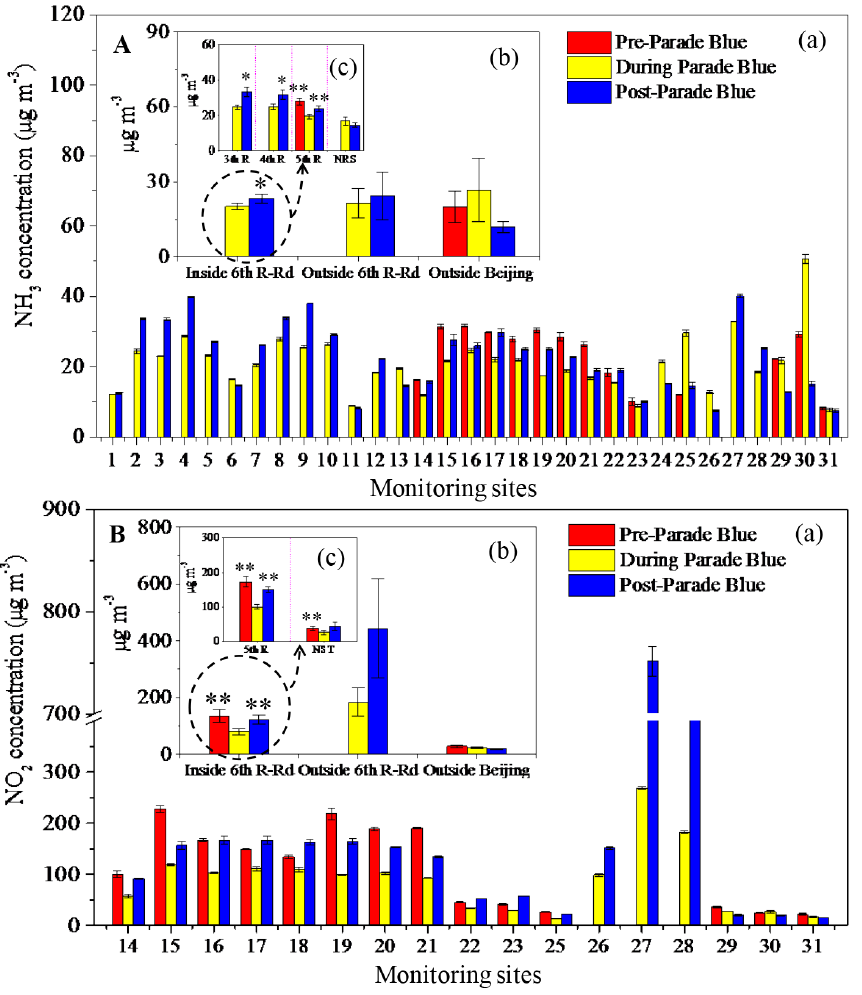
Figure 2. Concentrations of NH 3 (A) and NO 2 (B) during the monitoring periods at different observation scales: concentrations at 31 (NH 3 ) or 17 (NO 2 ) sites (a), averaged concentrations for the sites inside the sixth ring (R) road (Rd), outside the sixth ring (R) road (Rd) and outside Beijing (b), averaged concentrations for the sites on the third, fourth and/or fifth ring roads and non-road sites (NRS) (c). One asterisk on bars denotes significant difference at p < 0.05, while two asterisks on bars denote significant difference at p <